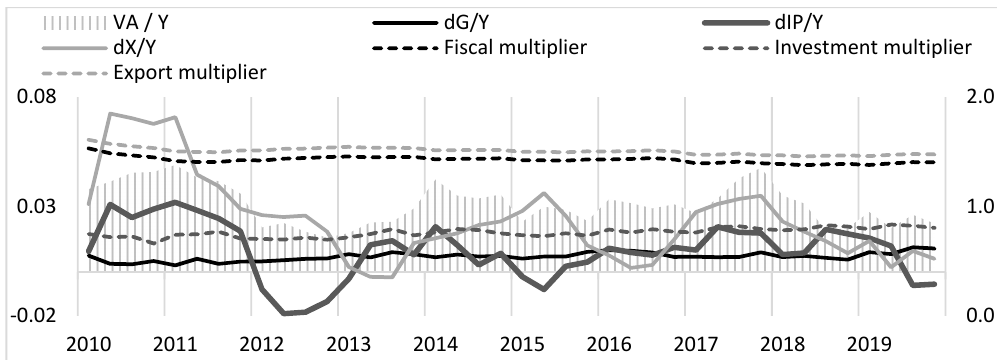
Figure 10. Growth rate of gross value added (main variables)—France, own work, source: Eurostat. Figure 11. Growth rate of gross value added (main variables)—Germany, own work, source: Eurostat.